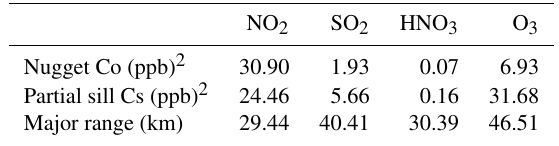
Table 3. Statistical parameters calculated for each interpolation